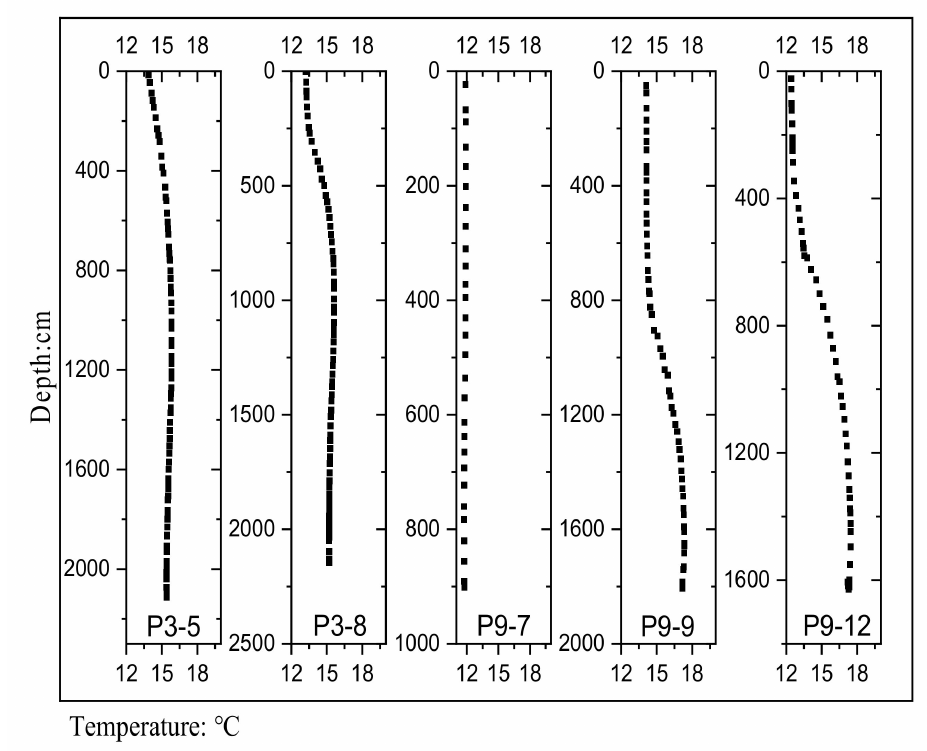
Figure 10. Temperature profiles of boreholes from the natural tracer